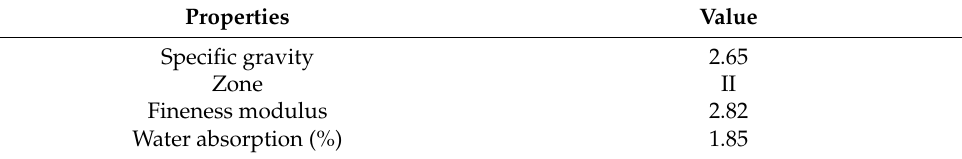
Table 3. Properties of fine